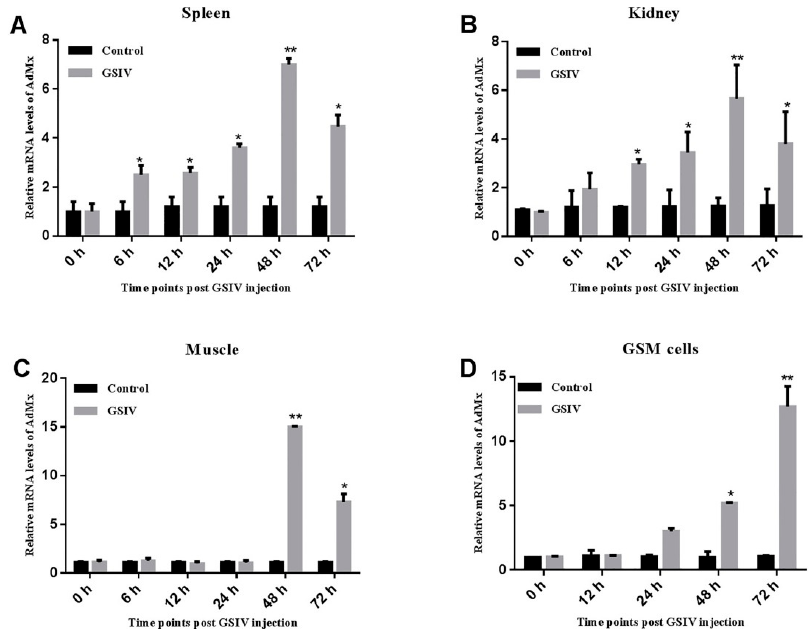
Figure 5. The mRNA expression pattern of AdMx in the spleen ( A ), kidney ( B ), muscle ( C ) and GSM cells ( D ) at indicate times post GSIV infection. The expression level of AdMx was determined by quantitative real time PCR (qRT-PCR) and all data were normalized to β -actin. For the convenience of comparison, the expression level in control at 0 h normalized to β -actin was set as 1. Error bars indicate the mean ± SD ( n = 3). The asterisks indicate significant di ff erence (** p < 0.01, * p < 0.05) between treated and control